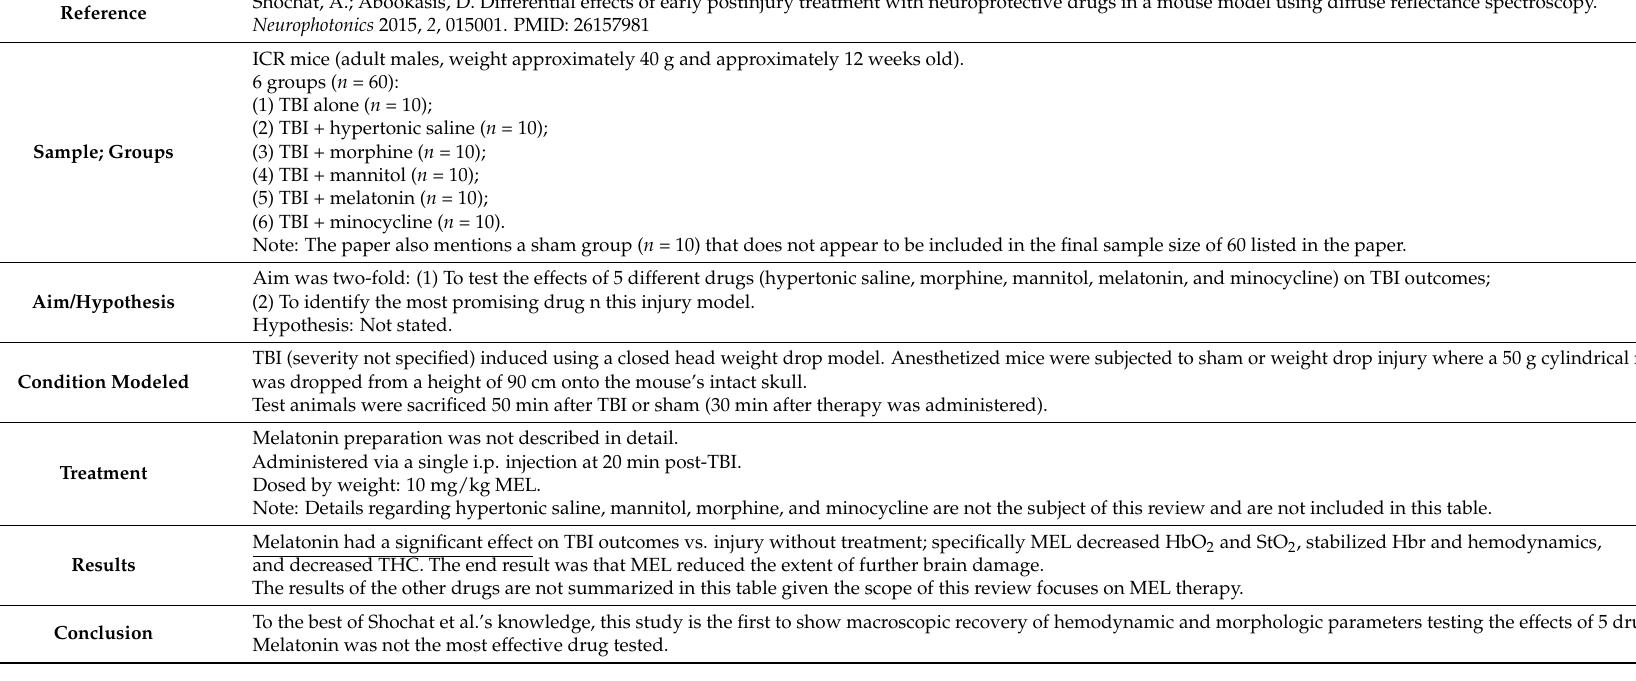
Table A18. Shochat et al. (2015) Study